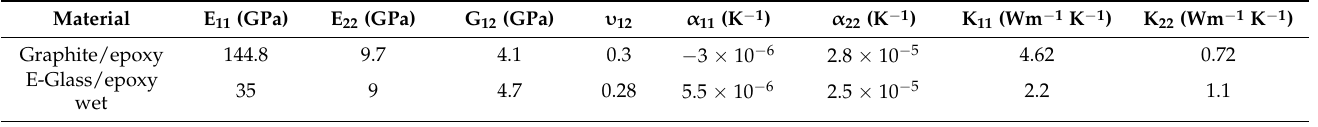
Table 1. Mechanical properties of the studied materials